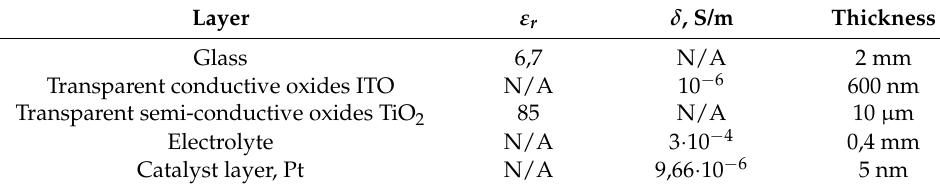
Table A1. Selected parameters of the material used in DSSC [31–34]. Layer ε r δ , S/m Thickness Glass 6,7 N/A 2 mm Transparent conductive oxides ITO N/A 10 − 6 600 nm Transparent semi-conductive oxides TiO 2 85 N/A 10 µ m Electrolyte N/A 3 · 10 − 4 0,4 mm Catalyst layer, Pt N/A 9,66 · 10 − 6 5